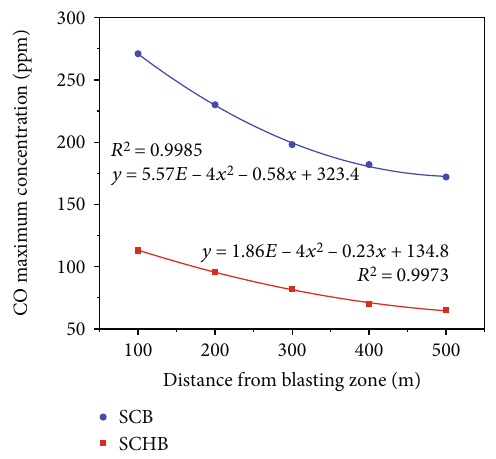
Figure 16: Changes in maximum CO concentration with monitoring distance in double-hole SCB and SCHB.